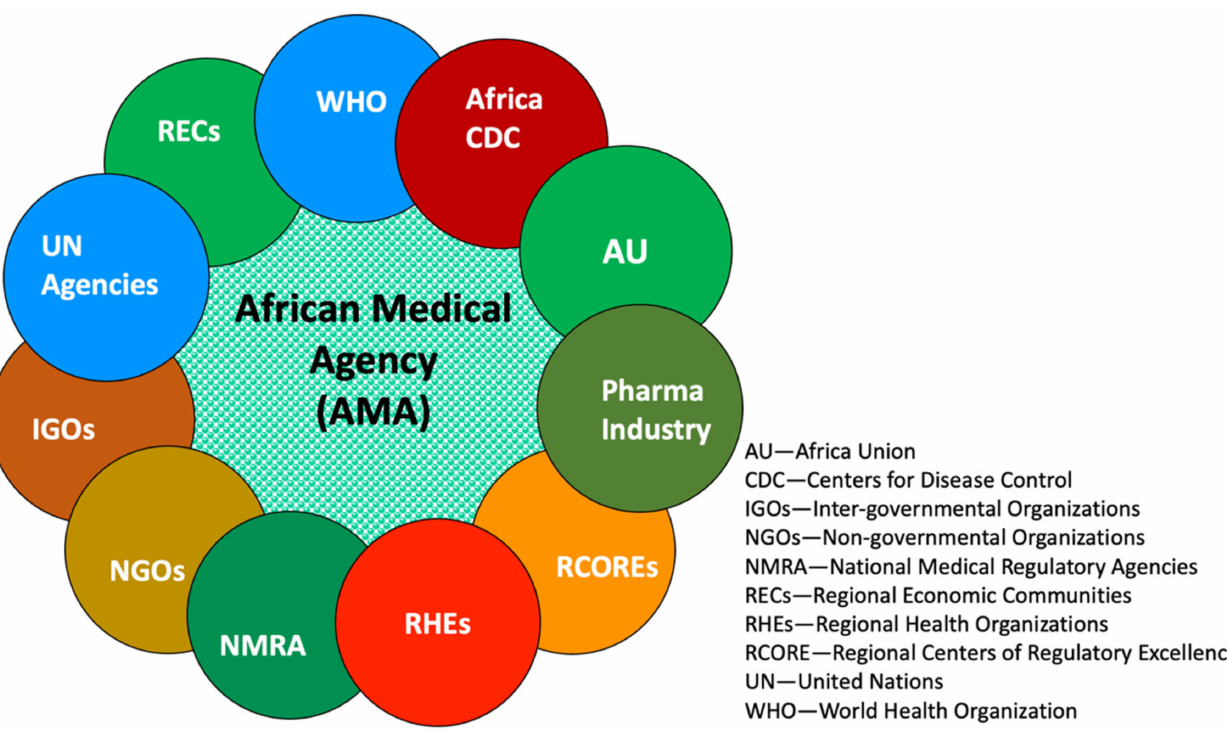
Figure 3. Engagement of African Medical Agency in health diplomacy with its main regional partners. Source: conceptual- ized by the